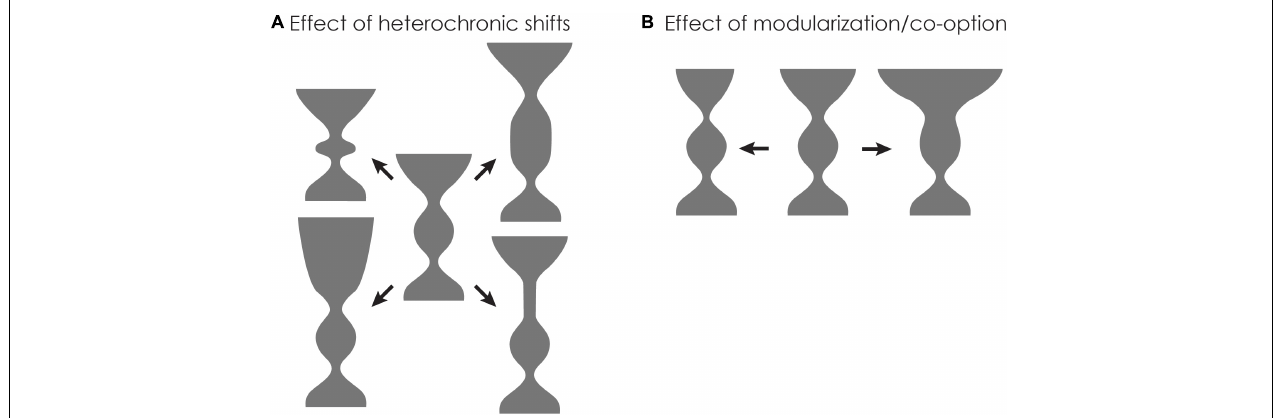
FIGURE 7 | Changes in developmental endocrinology in response to climate change can lead to changes in body size and metabolism/morphology. (A) Potential effects of heterochronic shifts on the shape of the developmental goblet. Changes in endocrine system can lead to alteration in duration of the larval or metamorphic stages. (B) Potential effects of modularization/co-option on the shape of the developmental goblet. Changes in endocrine system can lead to alteration in phenotypic diversity of the adult stages.